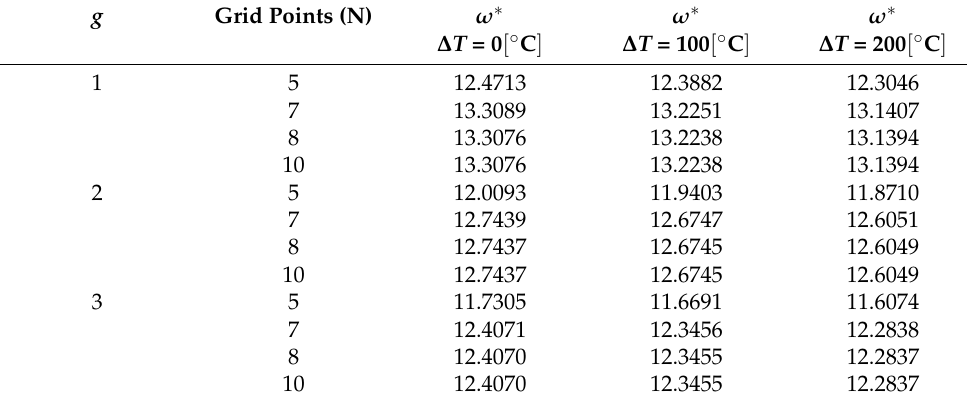
Table 4. Convergence behavior and accuracy of the DQM.